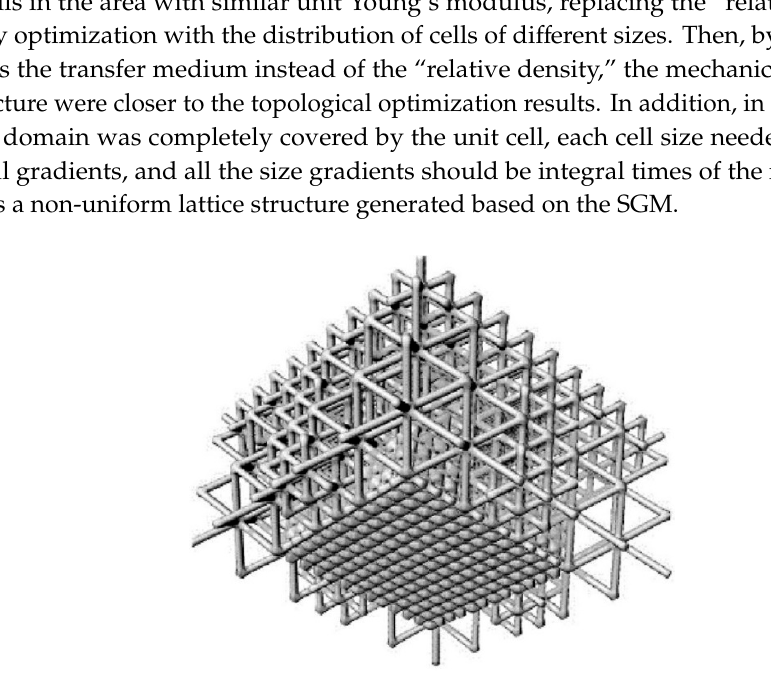
Figure 20. Non-uniform lattice structure based on SGM method [27].